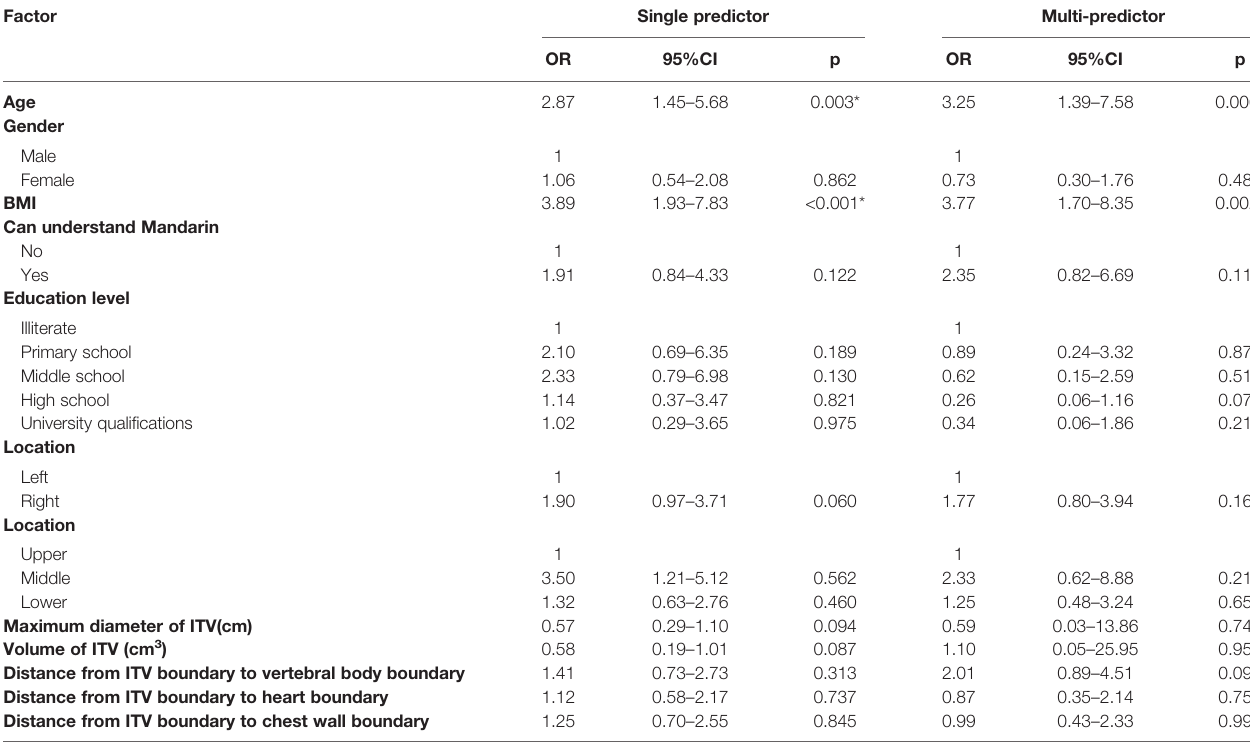
TABLE 5 | Correlation between patient re-setup with the clinical and tumor factors (translation error >5mm or rotation error >2° in any direction). Factor Single predictor